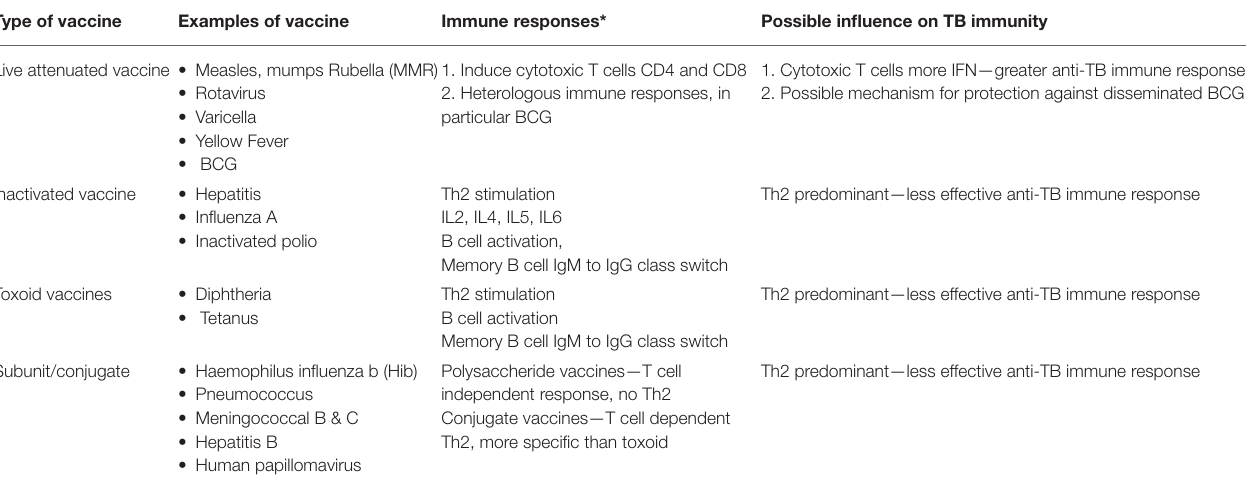
TABLE 2 | Type of vaccines and how they may influence susceptibility and protection to tuberculosis in children. Type of